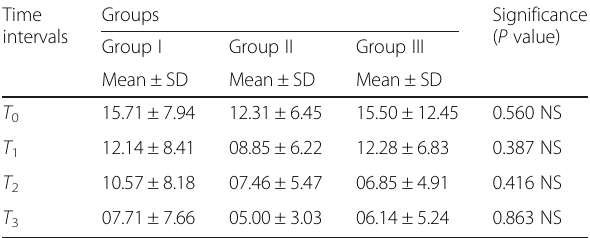
Table 3 Between the group comparisons of visual scores at various time intervals of observation Time intervals